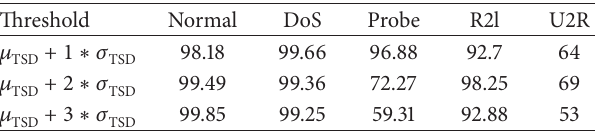
Table7:Accuracy(%)achievedbytheproposedsystemfordifferent